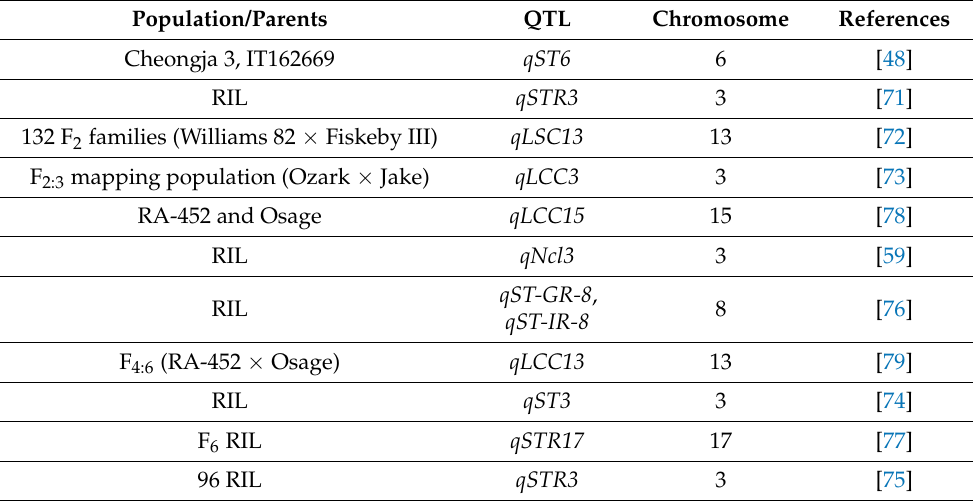
Table 3. Major salt-tolerant QTL identified in different soybean